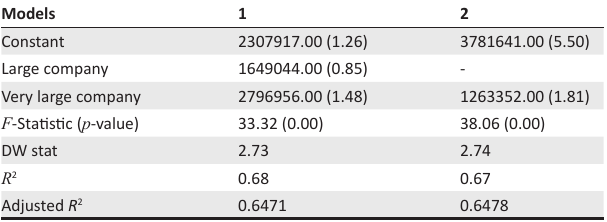
TABLE 6: Regression analysis – total compensation and company size. Models